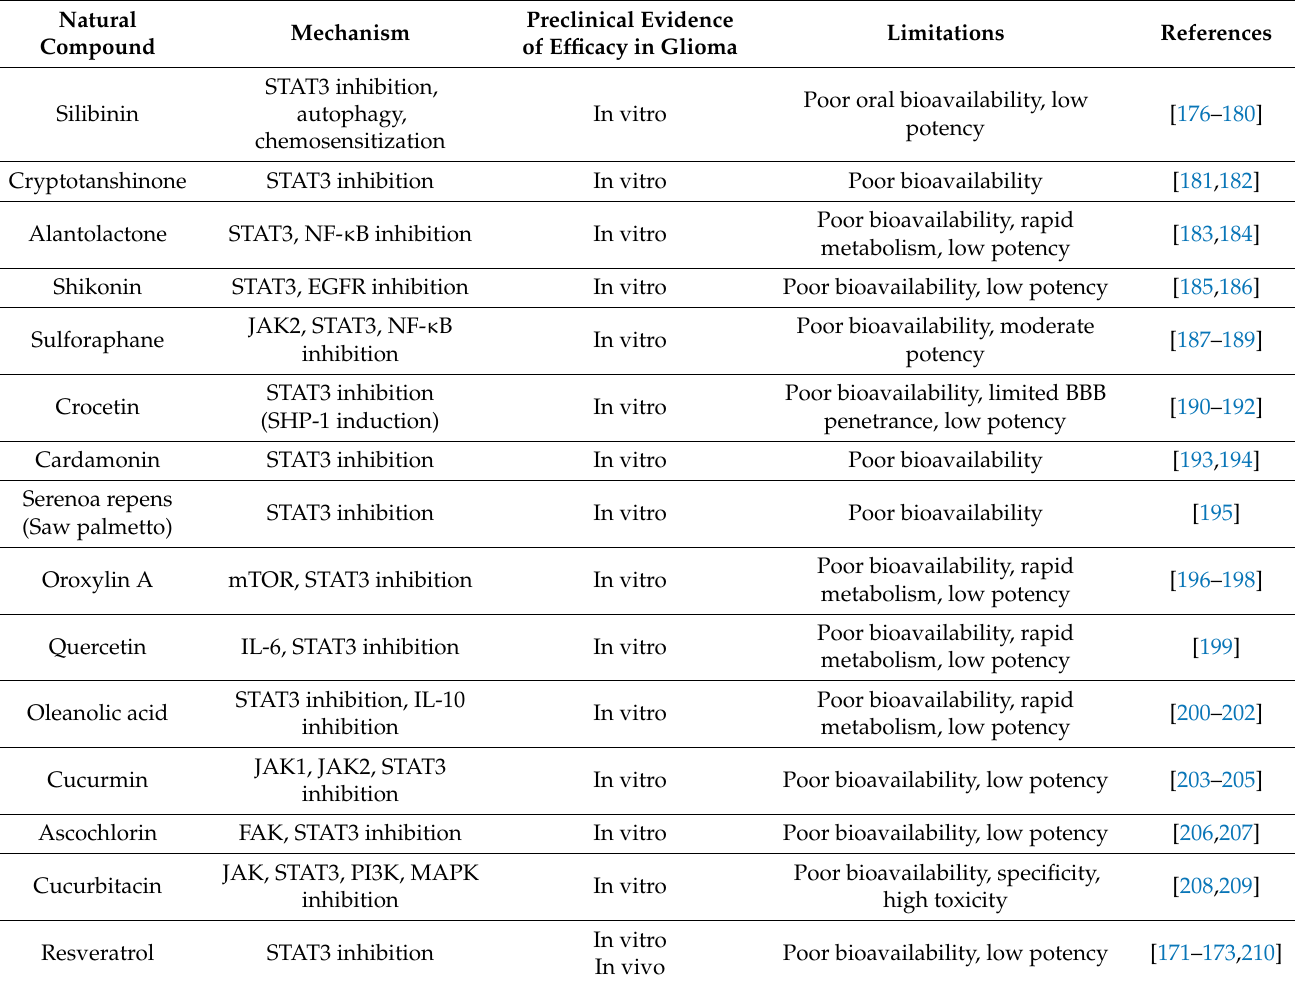
Table 1. Natural compounds with STAT3 inhibitory activity evaluated in